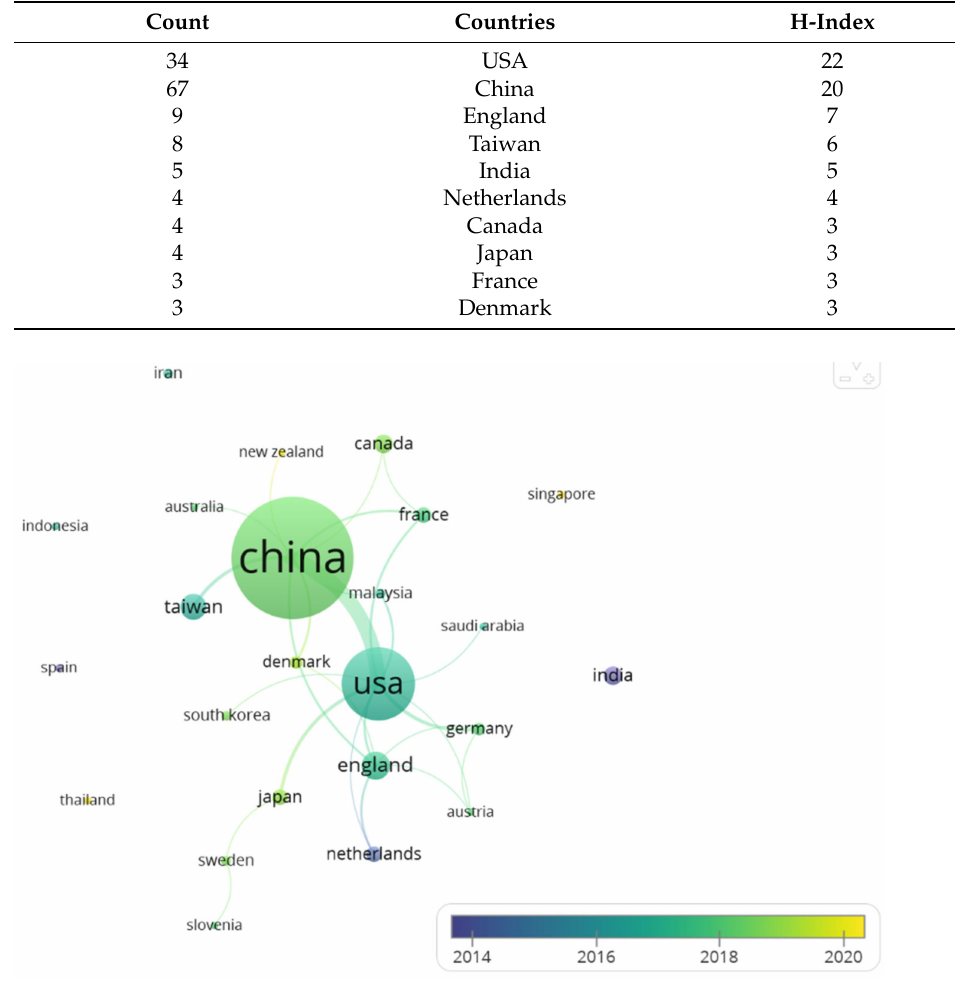
Figure 4. Visual map of the cooperation network of 24